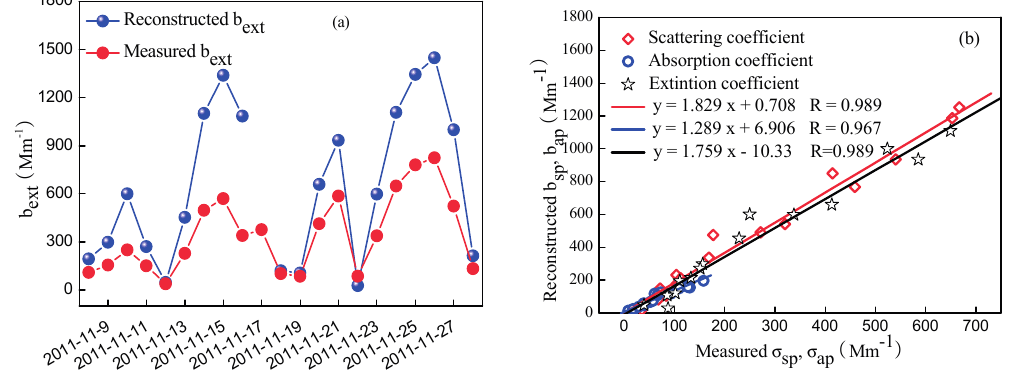
Figure 10. The temporal variations of measured and reconstructed b ext ( a ) and the correlation between measured and reconstructed optical parameters ( b ).